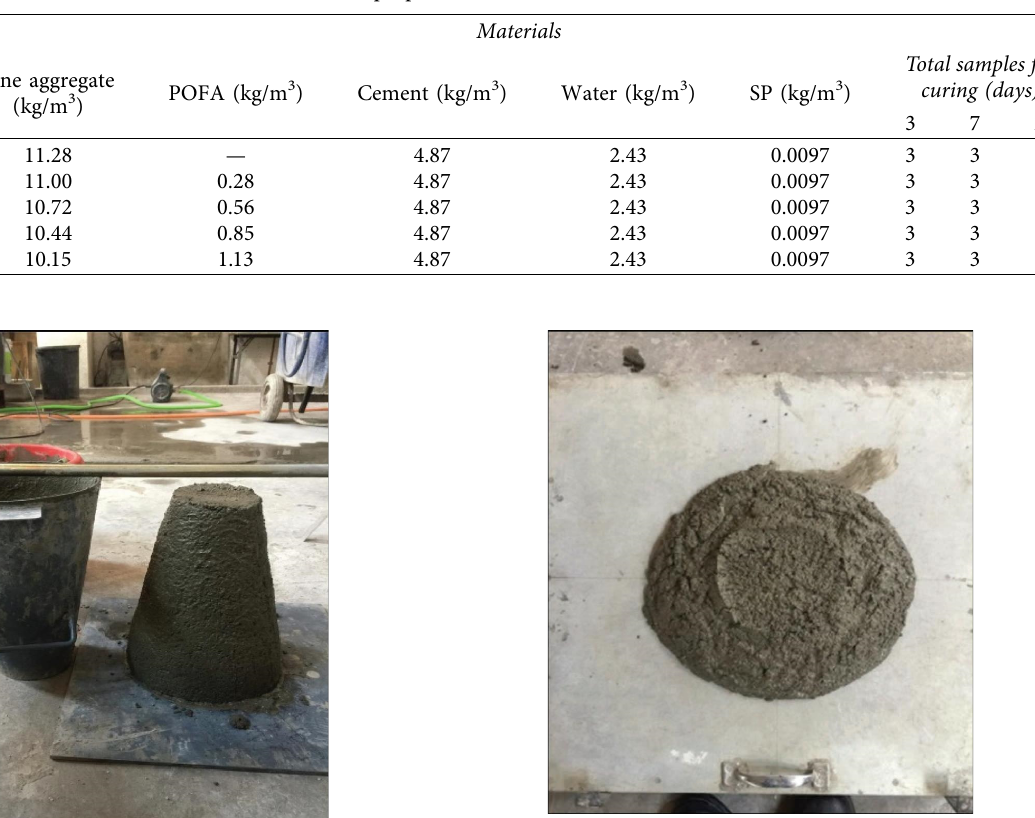
Figure 1: Raw POFA (a) and oven-dried POFA (b). Table 1: Mix proportion of mortar cubes.